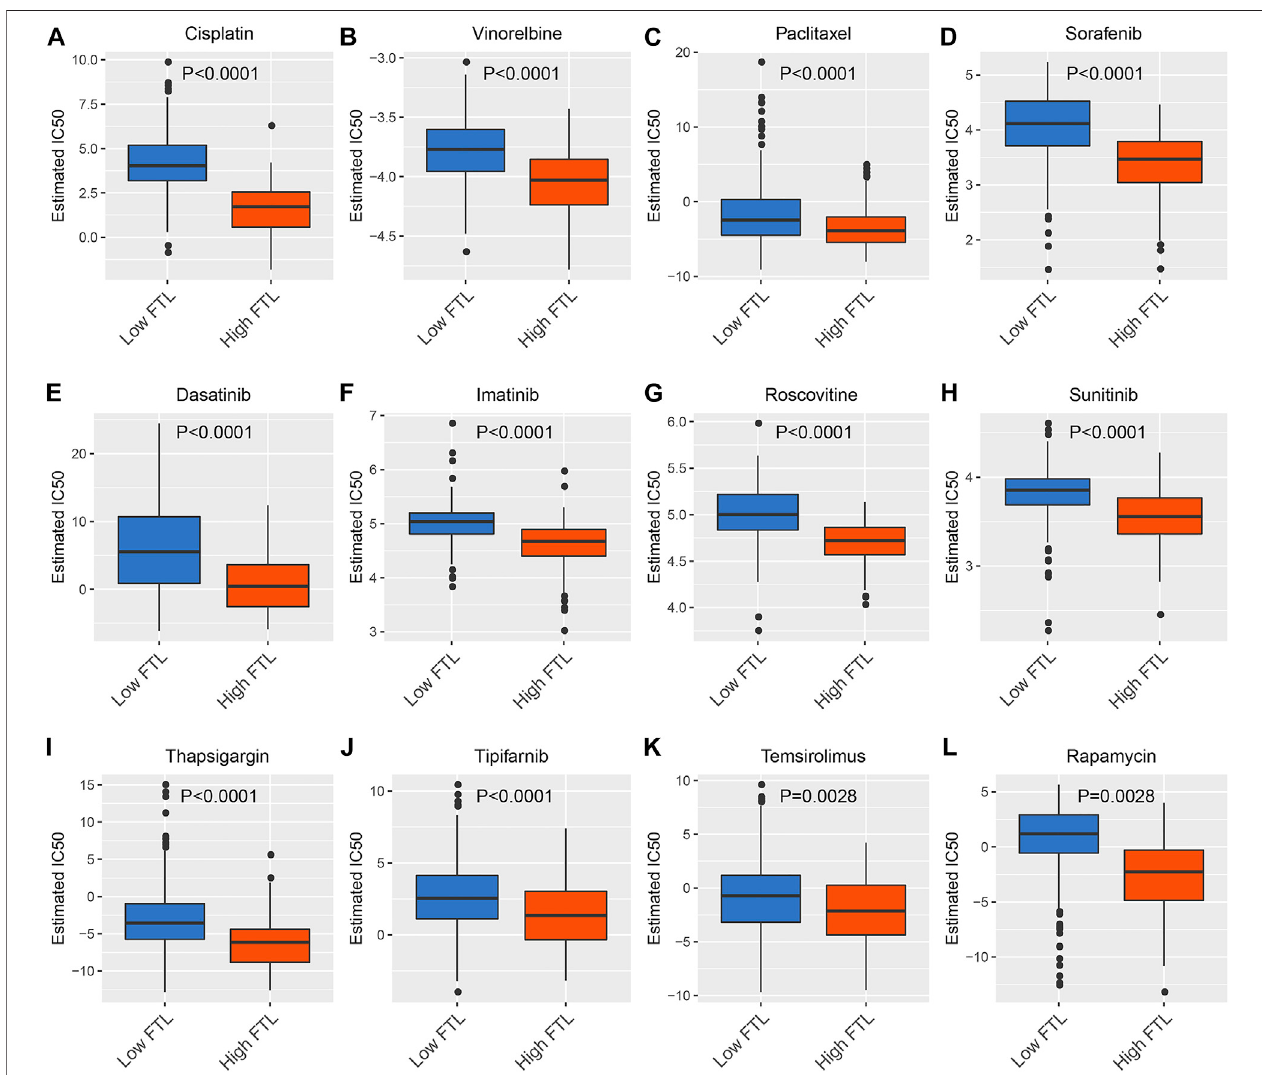
FIGURE6| PredictionofchemotherapeuticandtargetedtherapeuticresponsesinHCCpatientswithhighFTLandlowFTL. (A – C) Boxplotshowingtheprediction oftheIC50 valueoftraditionalchemotherapeuticdrugs, including cisplatin,paclitaxel,and vinorelbine,betweenthehighFTLand lowFTLgroupsofHCC patients. (D-L) Box plot showing the prediction of the IC50 value of targeted drugs, including sorafenib, dasatinib, imatinib, roscovitine, sunitinib, thapsigargin, tipifarnib, temsirolimus, and rapamycin, in HCC patients with high FTL compared with the low FTL group.